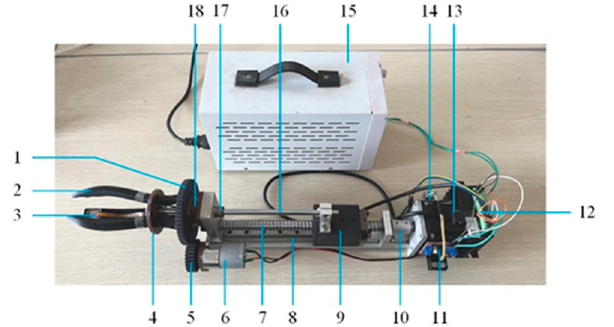
Figure 3. The design of end-effector for small spherical fruit picking. Note: 1, Chassis; 2, Finger; 3, Pressure sensors; 4, Constraint Part; 5, Gear; 6, DC Motor; 7, Screw; 8, Slide track; 9, Slider; 10, Coupling; 11, DC motor drivers; 12, Stepper motor driver; 13, Stepper motor; 14, Arduino control panel; 15, Power; 16, Pole; 17, Linear bearings; 18, Change the